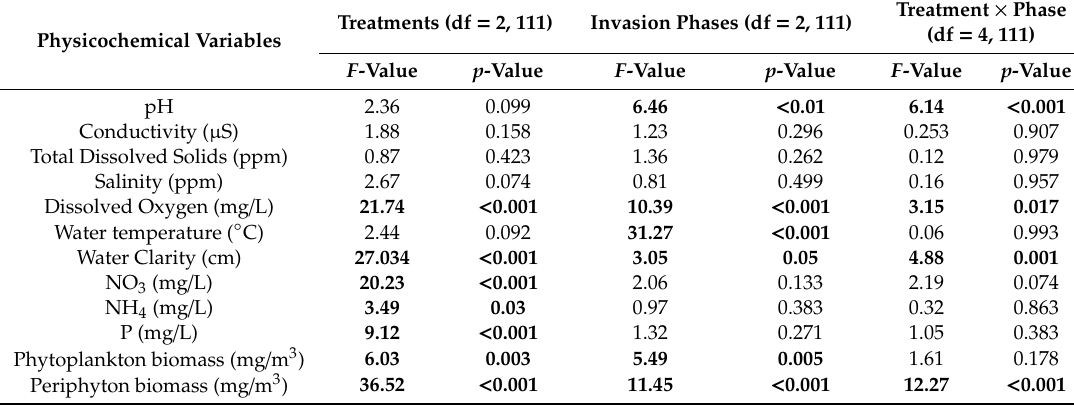
Table 1. Summary of two-way ANOVA representing statistics of all physicochemical variables collected during the before–after control–impact study. Significant di ff erences ( p < 0.05) are highlighted in bold. Mean and standard deviation physicochemical variable per treatment and invasion phase are presented in Table S1. df—degrees of